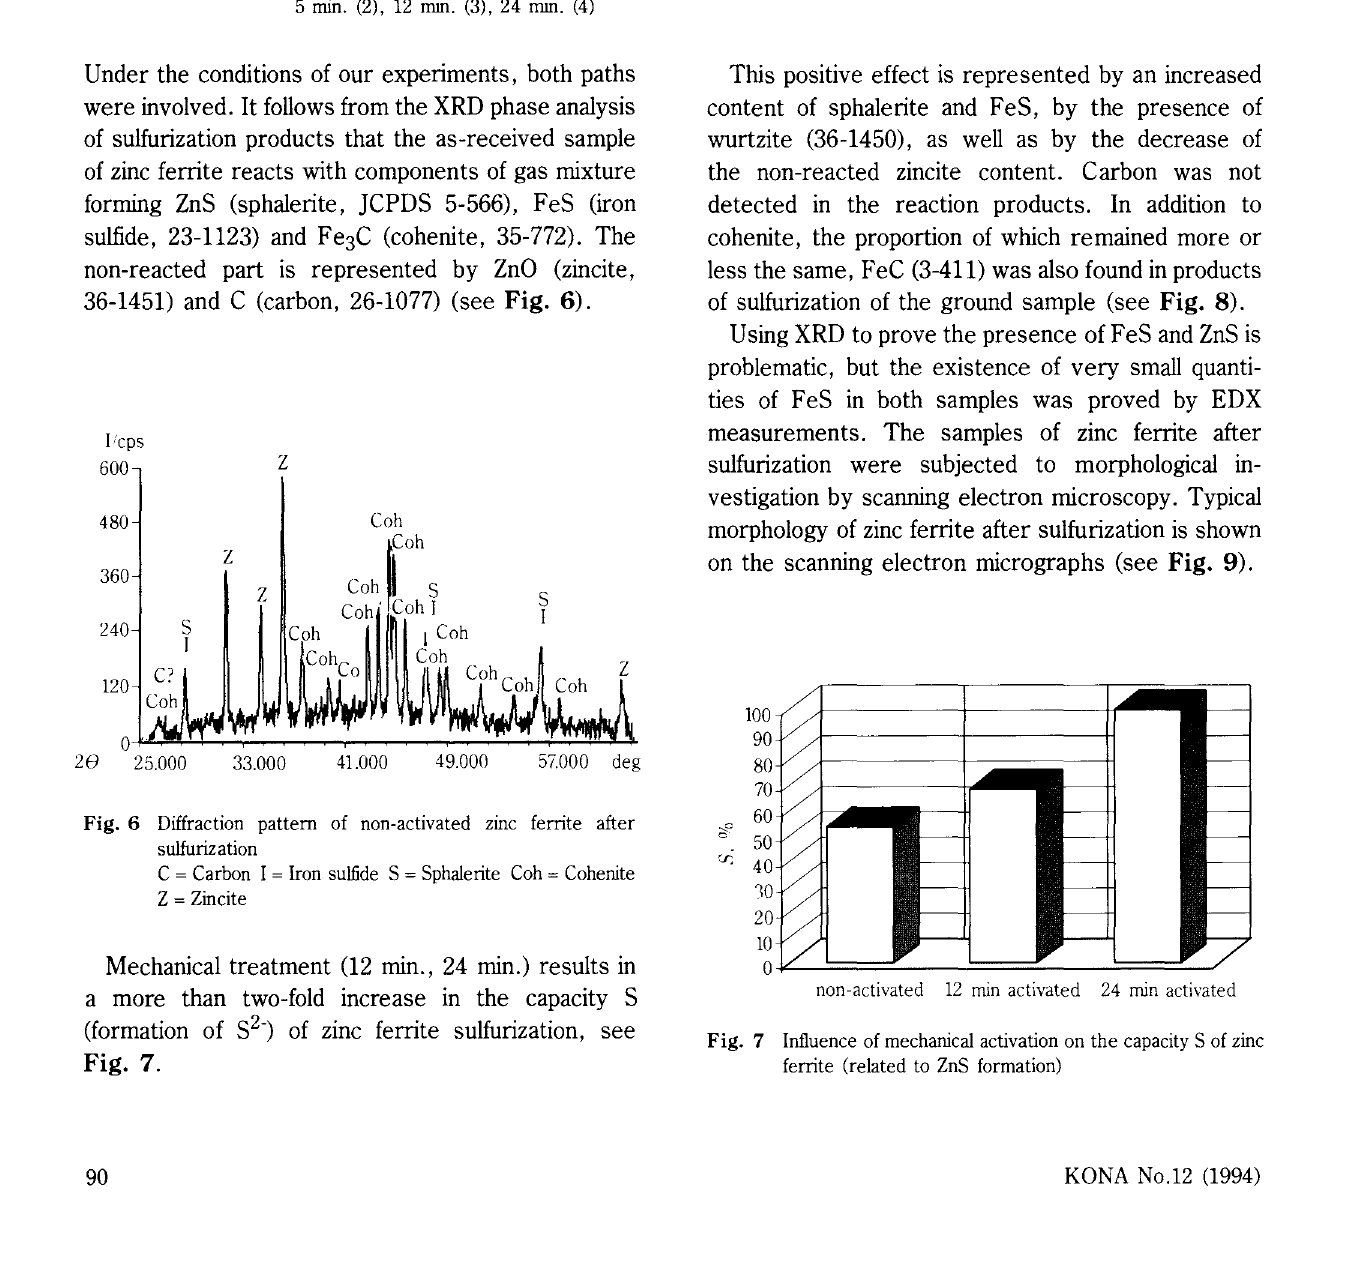
Fig.S Miissbauer spectrum of non-activated zinc ferrite (1) and of zinc ferrite mechanically activated for 5 min. (2), 12 min. (3), 24 min. (4)